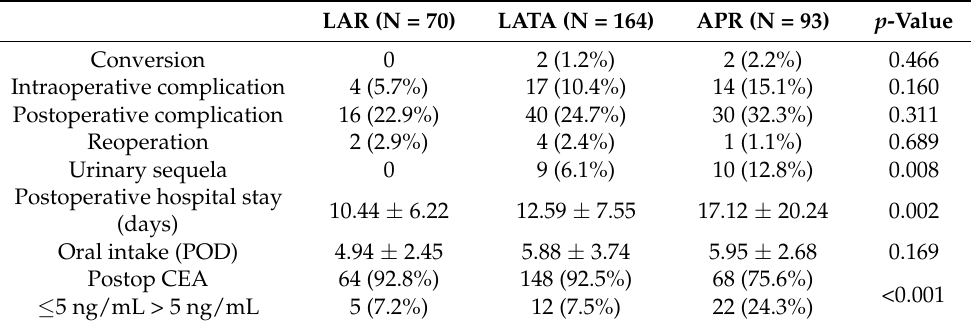
Table 2. Perioperative short-term outcomes and postoperative findings.